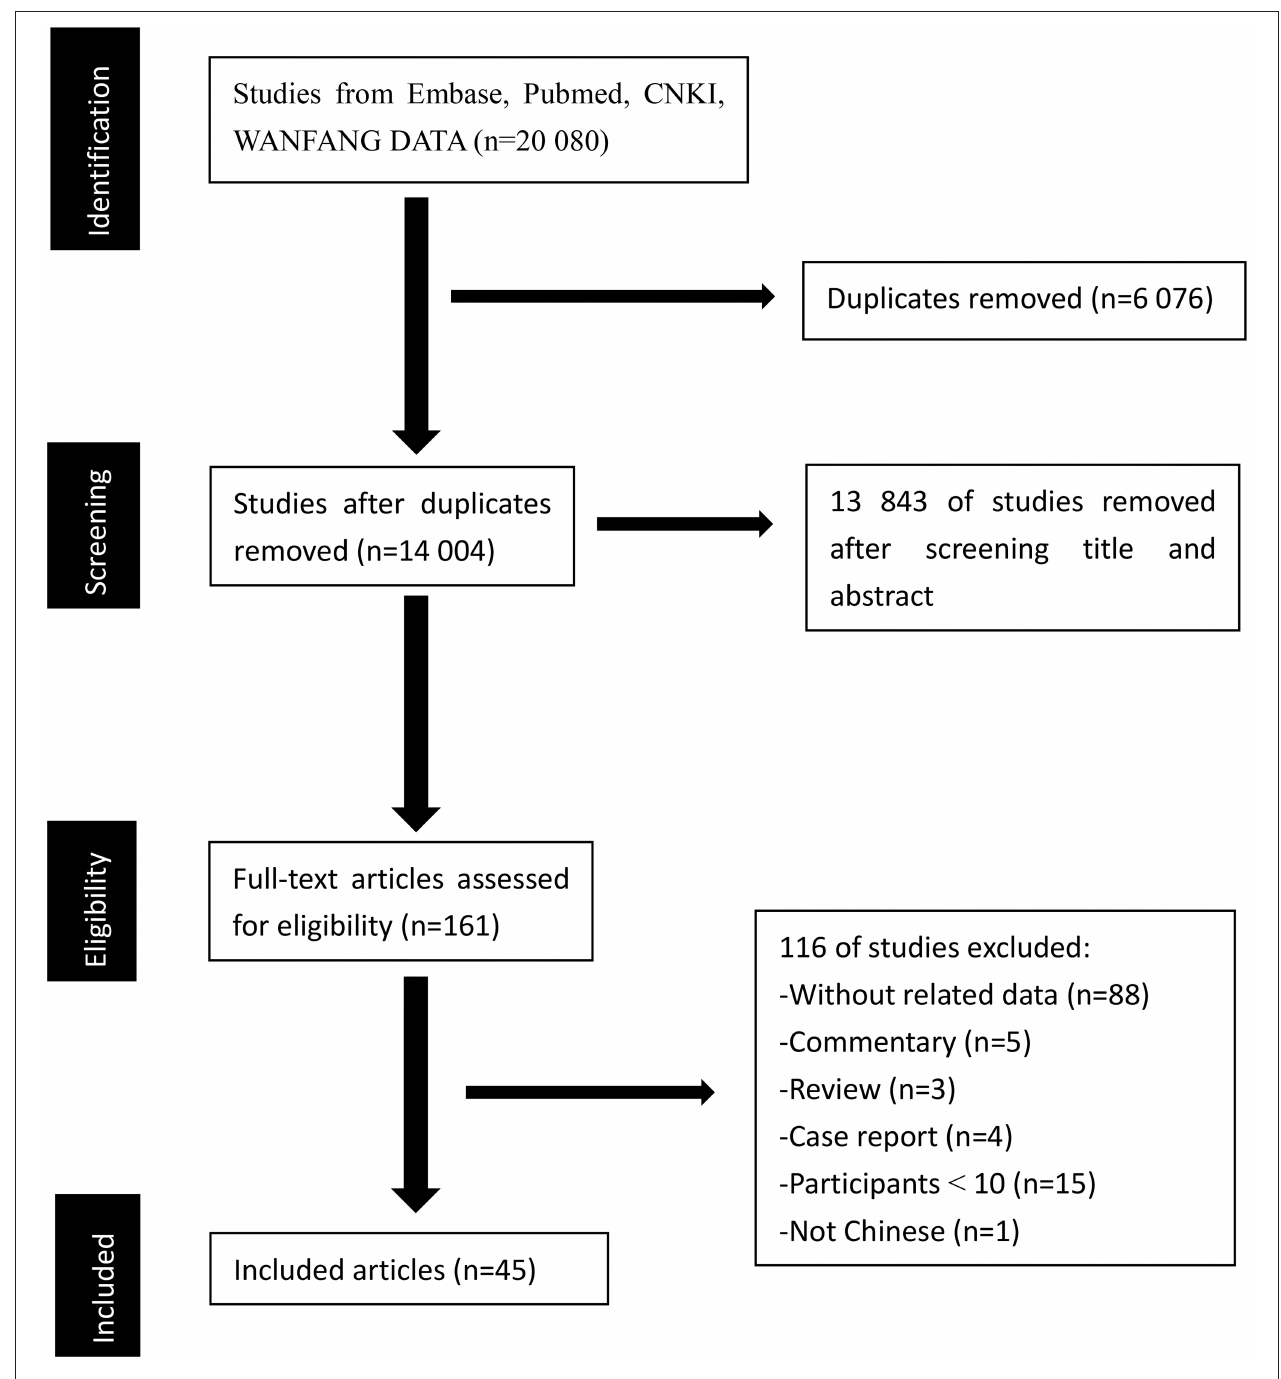
FIGURE 1 | PRISMA diagram of the article selection.